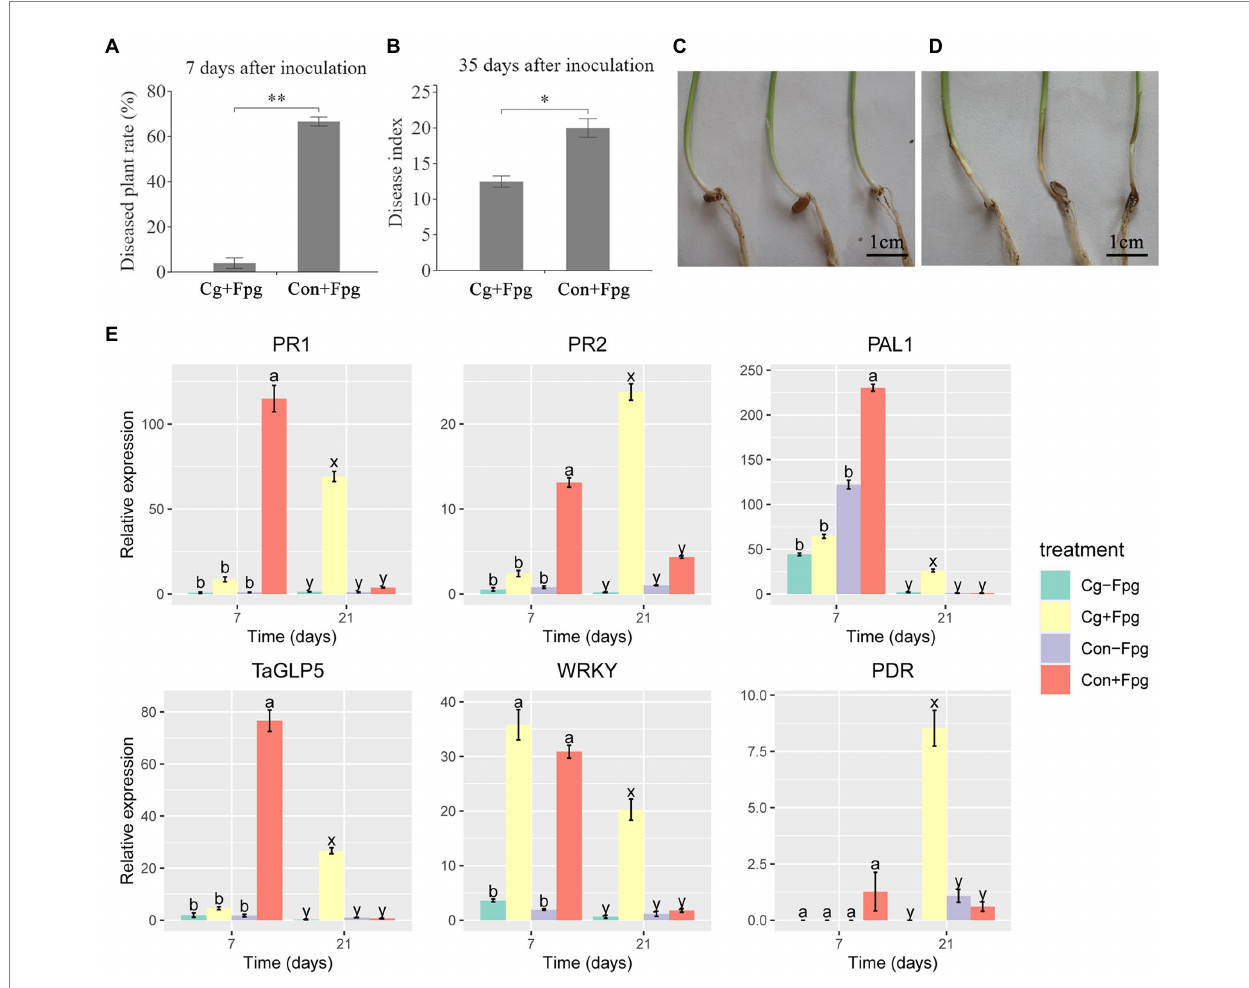
FIGURE 2 Control effect of seed coating with Chaetomium globosum 12XP1-2-3 on wheat FCR through indoor inoculation. (A) Diseased plant rates 7 days after inoculation with F. pseudograminearum G14LY24–2; (B) Disease index 35 days after inoculation; (C,D) Stem base of wheat seedlings 7 days after inoculation. (C) Cg + Fpg, (D) Con + Fpg; (E) Relative expression of six defense-related genes in wheat seedlings 7 days and 21 days after inoculation by F. pseudograminearum G14LY24-2. Cg + Fpg, C. globosum coated seeds plus inoculation of F. pseudograminearum ; Con+Fpg, control seeds plus inoculation of F. pseudograminearum ; Cg-Fpg, C. globosum coated seeds without inoculation of F. pseudograminearum ; Con-Fpg, control seeds without inoculation of F. pseudograminearum . Detailed information of the genes were shown in Supplementary Table 1. Data were presented as